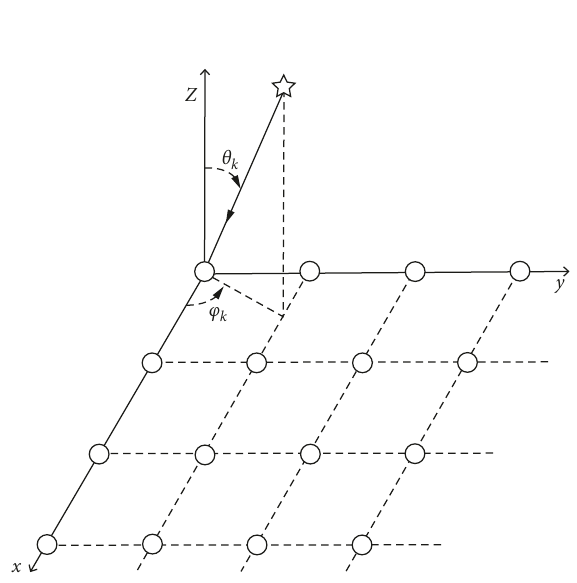
Figure 1: Signal arrives in